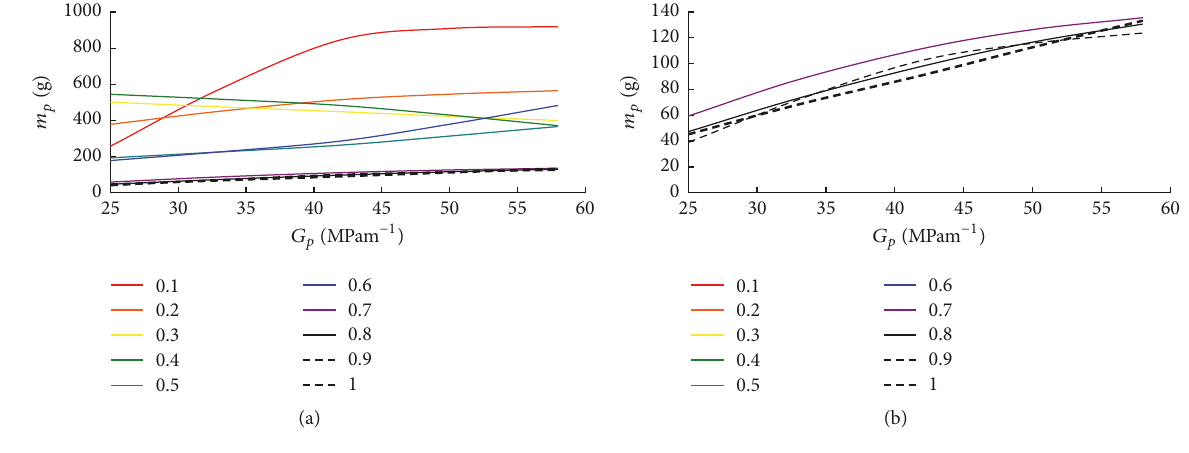
Figure 5: Variation of mass loss with pressure gradient.